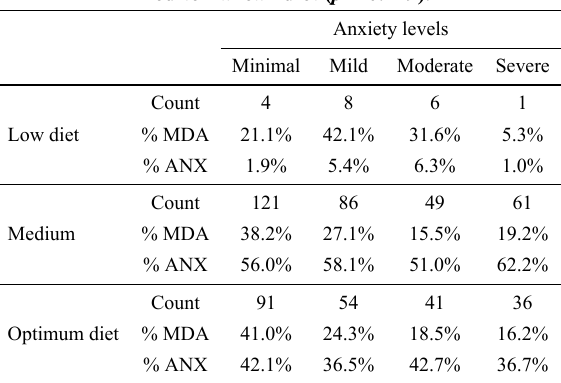
Table 5. Relationship between anxiety and adherence to Mediterranean diet ( p =